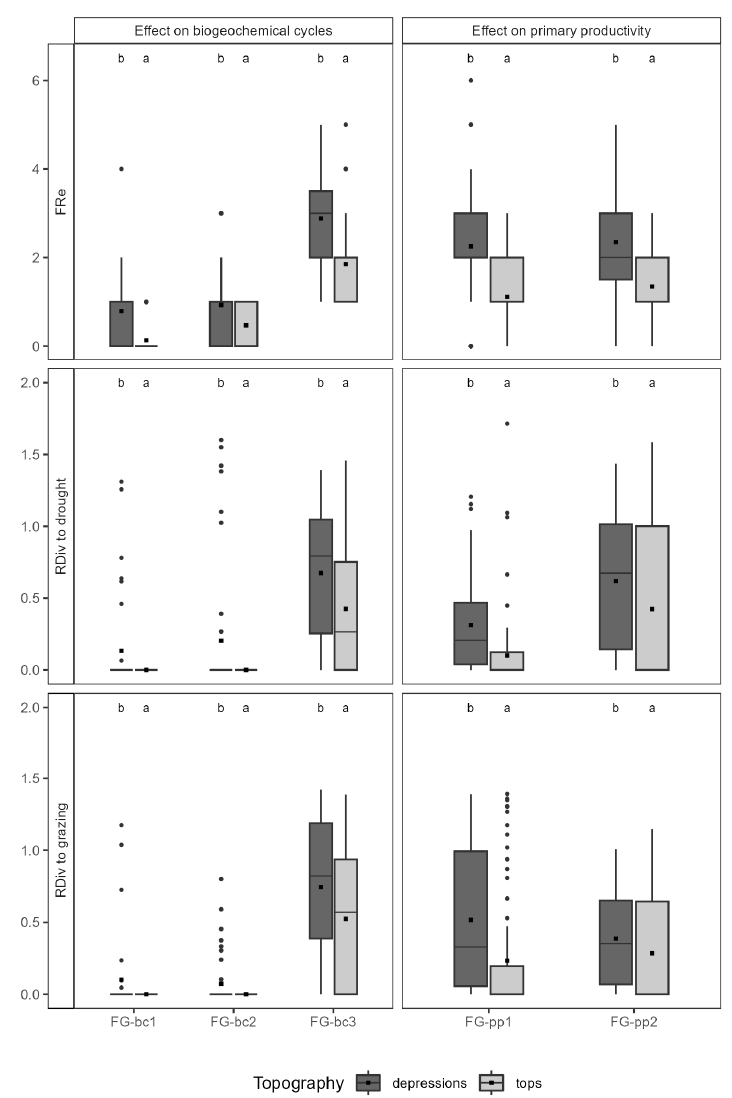
Figure 6. FRe and Rdiv to the two pressures for primary productivity (FG-pp) and biogeochemical cycles (FG-bc), according to the topography ( n = 139 plots). The means are represented by the squares. The letters indicate the differences between topographic elements according to the Wilcoxon’s tests ( p < 0.05).